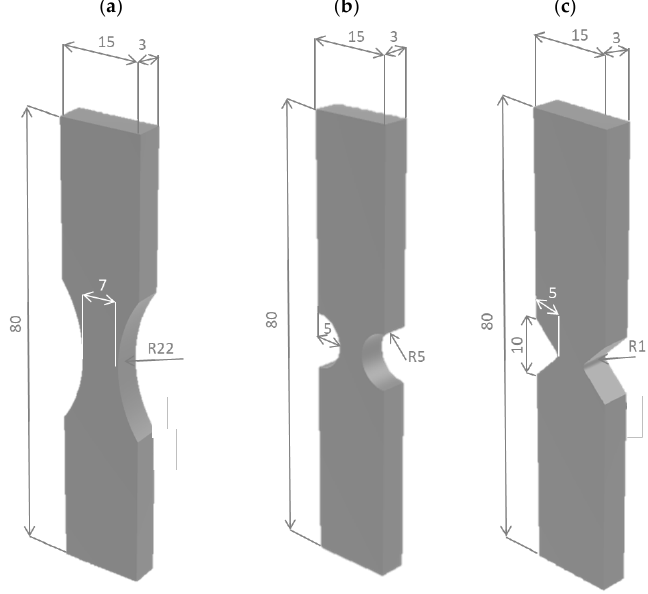
Figure 1. Schematic representation of the specimen geometries.